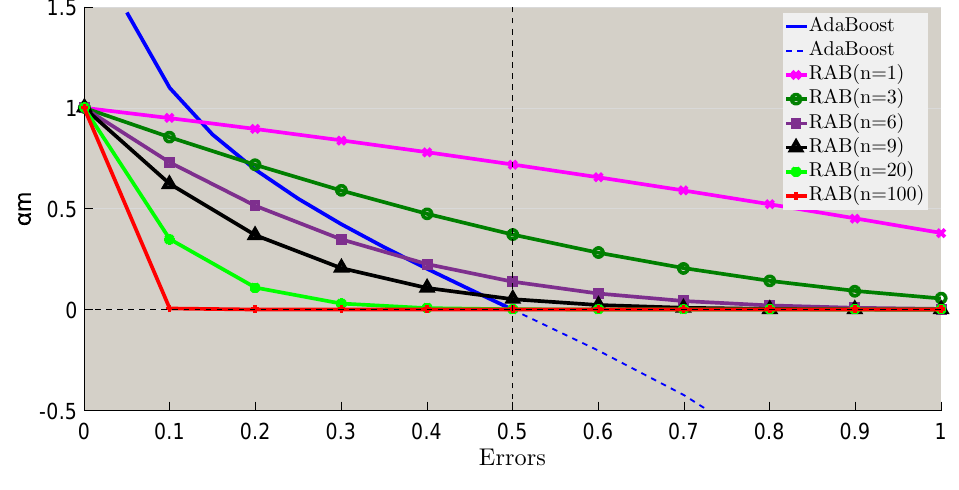
Figure 7. Base classifier weights